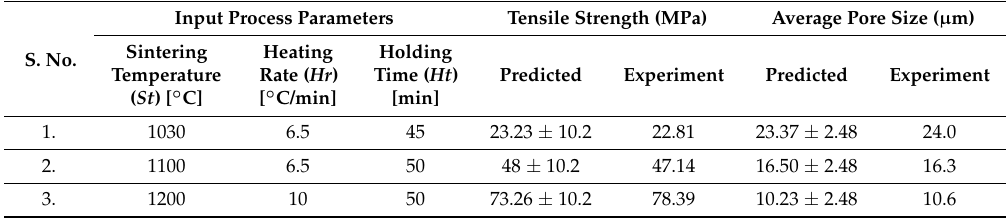
Table 3. Confirmation experiments for the developed statistical